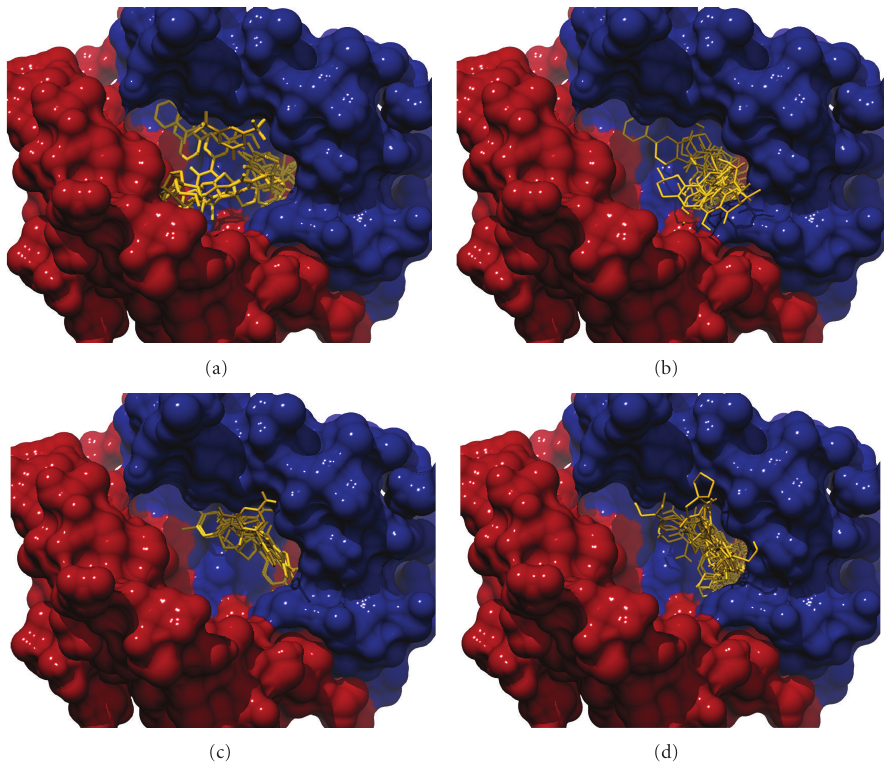
Figure 2: Orientation of inhibitors segregated into four di ff erent clusters at the active site of TR. Inhibitors in Cluster 1 (a) position themselves between both the hydrophobic patches of the active site, Cluster 2 (b) bind to the Z site with their side chains orienting themselves towards the negatively charged residues of the active site. In Cluster 3 (c), the ligands primarily bind to the negatively charged residues such as Glu466, Glu467 residues involved in orientation of active site histidine during hydride transfer process, in Cluster 4 (d) comprise of compounds which stack to the Z site, in the vicinity of the active site and they also interact with Lys61 of the substrate-binding